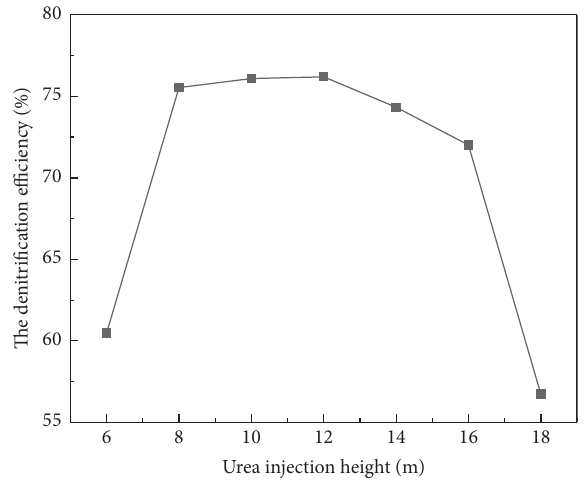
Figure 7: Denitrification efficiency under different injection positions.